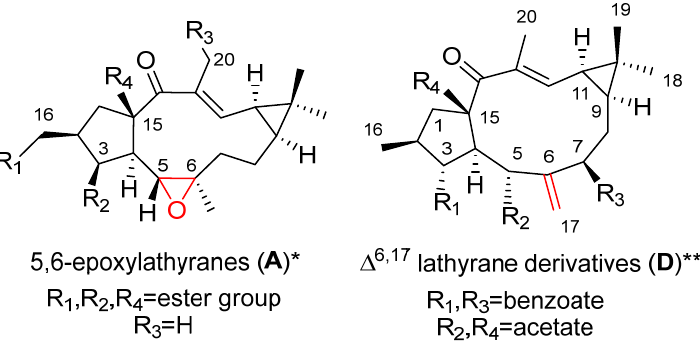
Figure 11. Selected functionalization patterns in active Ingol tupe diterpenes evaluated for their activity against cancer cell lines. ( A ) Functionalization pattern in 5,6-epoxylathyranes; ( D ) Functionalization pattern in Δ 6,17 lathyranes. Due to the variety of the cell lines investigated and the reduced number of compounds explored against each cell line, no further comparison can be drawn. * Patterns for active compounds evaluated against multidrug-resistant EPG85-257RDB cells. ** Patterns for active compounds evaluated against KB-VIN cells.